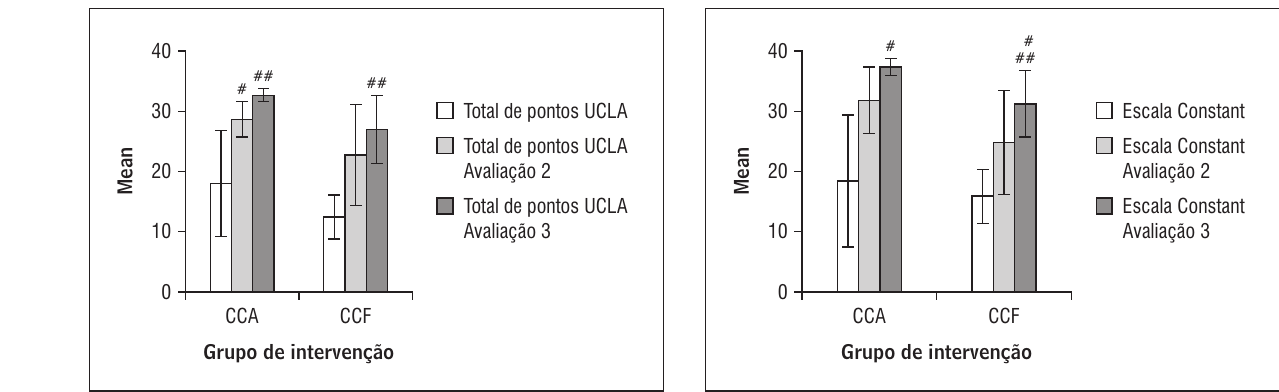
Figura 1 - Análise da avaliação UCLA ambos os grupos Legenda: # p = 0,02 avaliação inicial para avaliação parcial com dez sessões; ## p = 0,003 para grupo CCF e p = 0,022 para grupo CCA avaliação inicial para avaliação fi nal.